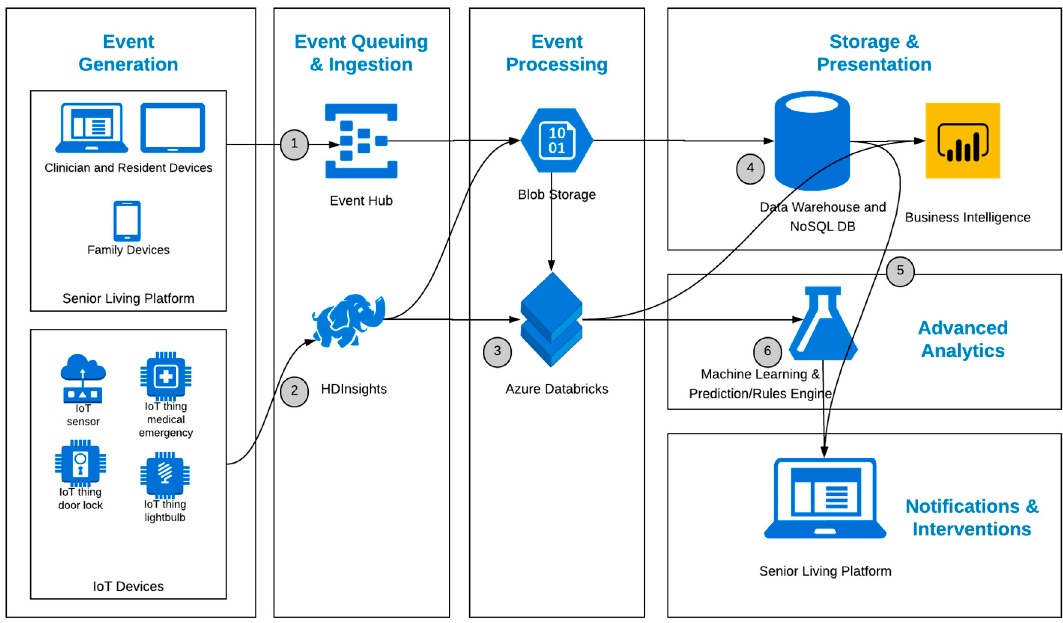
Figure 6. High-level technical architecture.